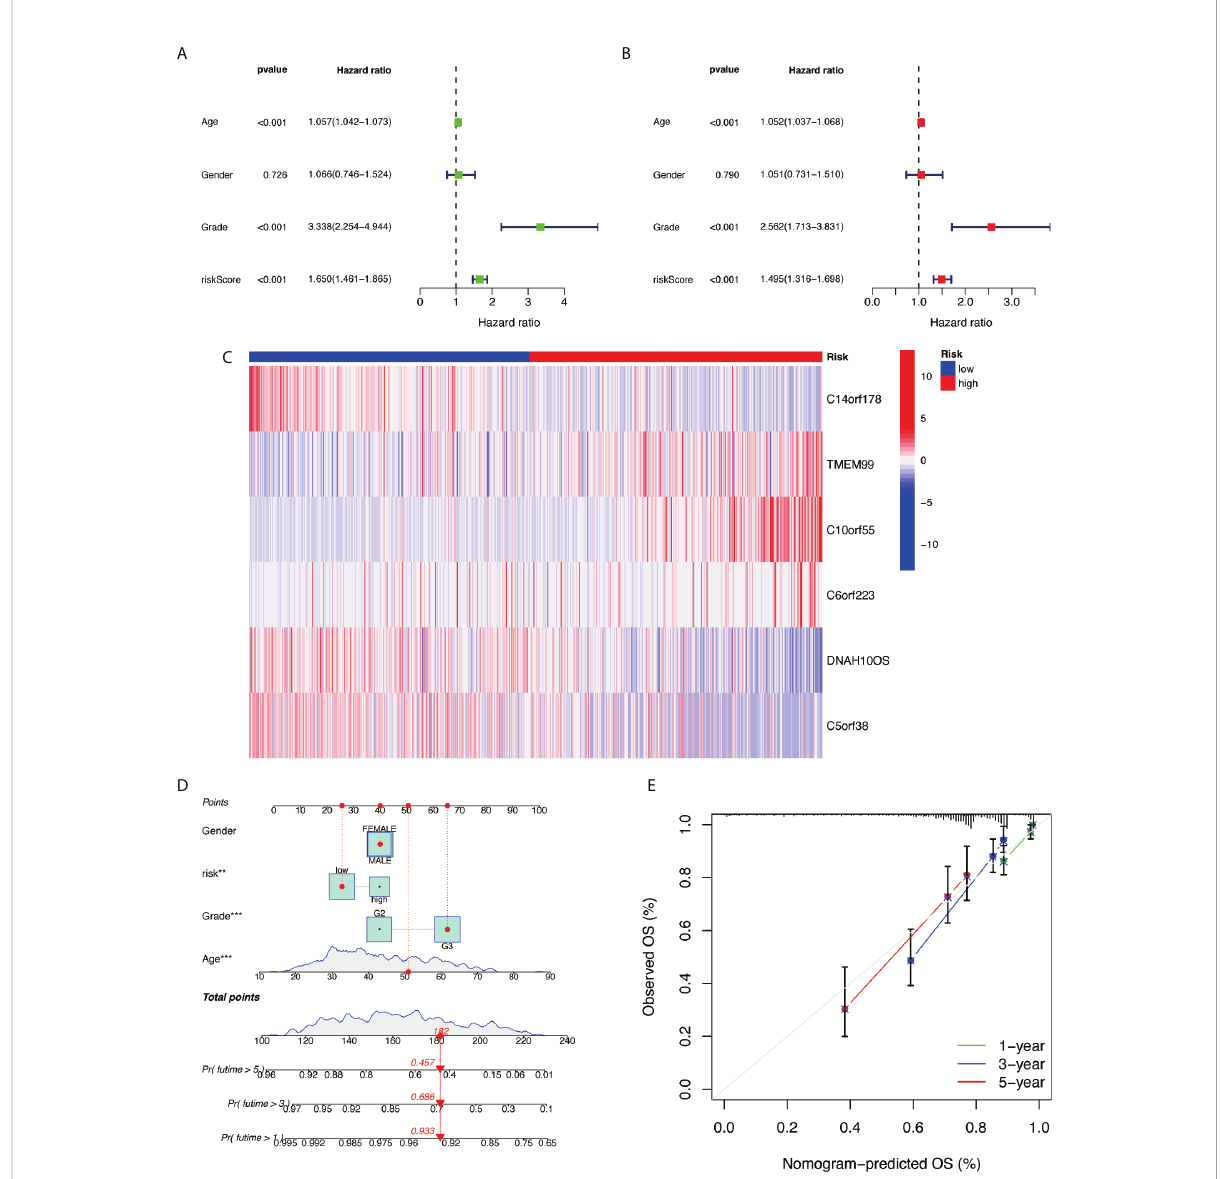
FIGURE 6 Prognostic nomogram construction. (A) Univariate Cox analysis. (B) Multivariate Cox analysis. (C) Model gene expression heat map between high/low risk. (D) Nomograph plot of predicted 1-, 3-, and 5-year overall survival probability based on prognosis signature. (E) Calibration plots of the nomogram for predicting the probability of OS at 1, 3, and 5 years in TCGA. OS, overall survival; TCGA, The Cancer Genome